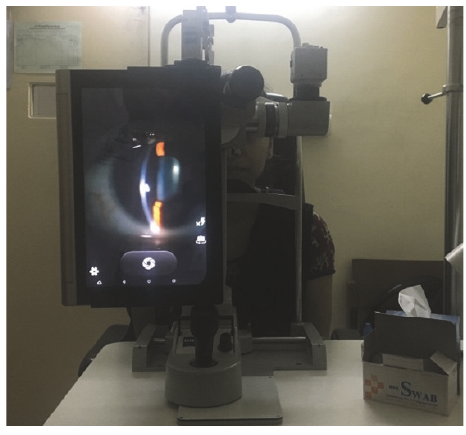
Figure 15: eyeSmart Cyclops attached to the slit lamp.